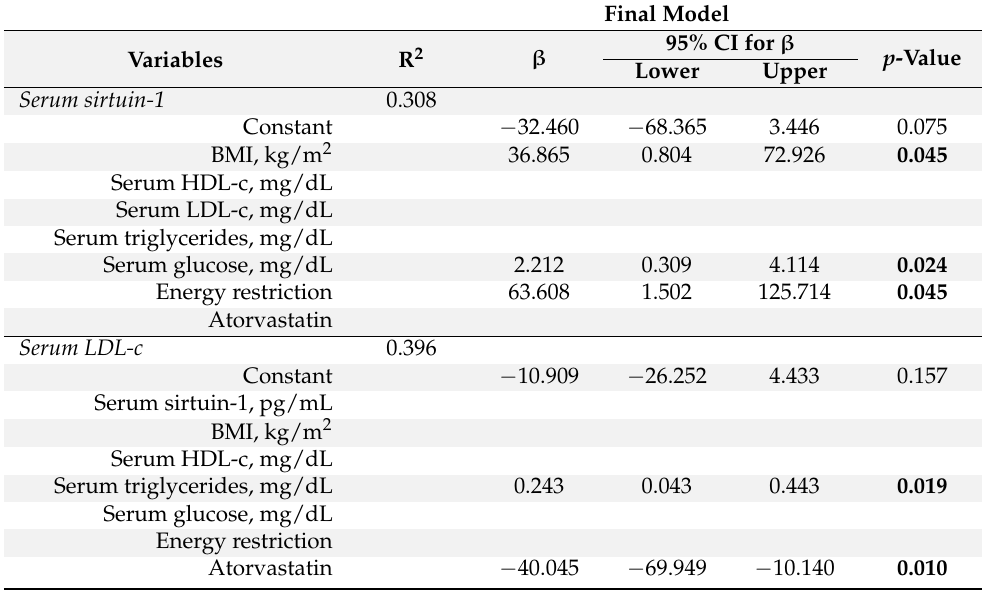
Table 2. Effects of interventions and variables’ changes on risk factors and serum